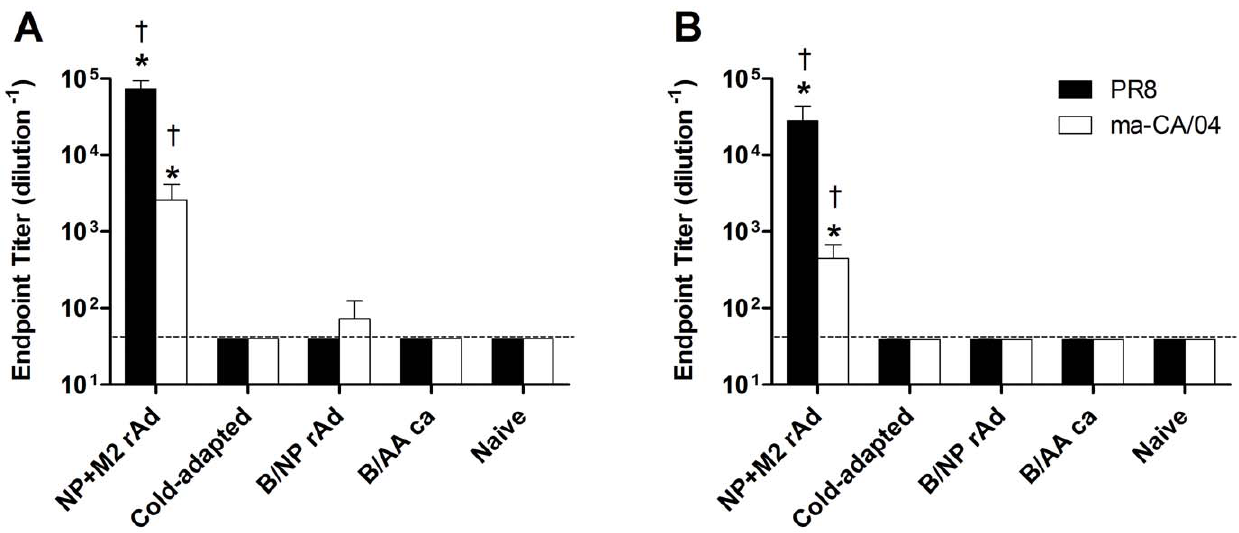
Figure 2. Anti-M2e serum antibody titers. Anti-M2e IgG levels in the serum of immunized mice at various timepoints following immunization. BALB/c (A and B) mice were immunized as in Figure 1 or left unvaccinated. Serum was obtained at 3 weeks (A) or 5 weeks (B) post-vaccination and tested for anti-M2e IgG antibody. Anti-M2e titers were determined using the PR8 peptide sequence (solid bars) and the ma-CA/04 peptide sequence (open bars). Shown are the mean endpoint titers 6 SD; n=5 per group. * P # 0.0001 versus naı¨ve, { P # 0.05 versus ca ; One Way ANOVA with Student-